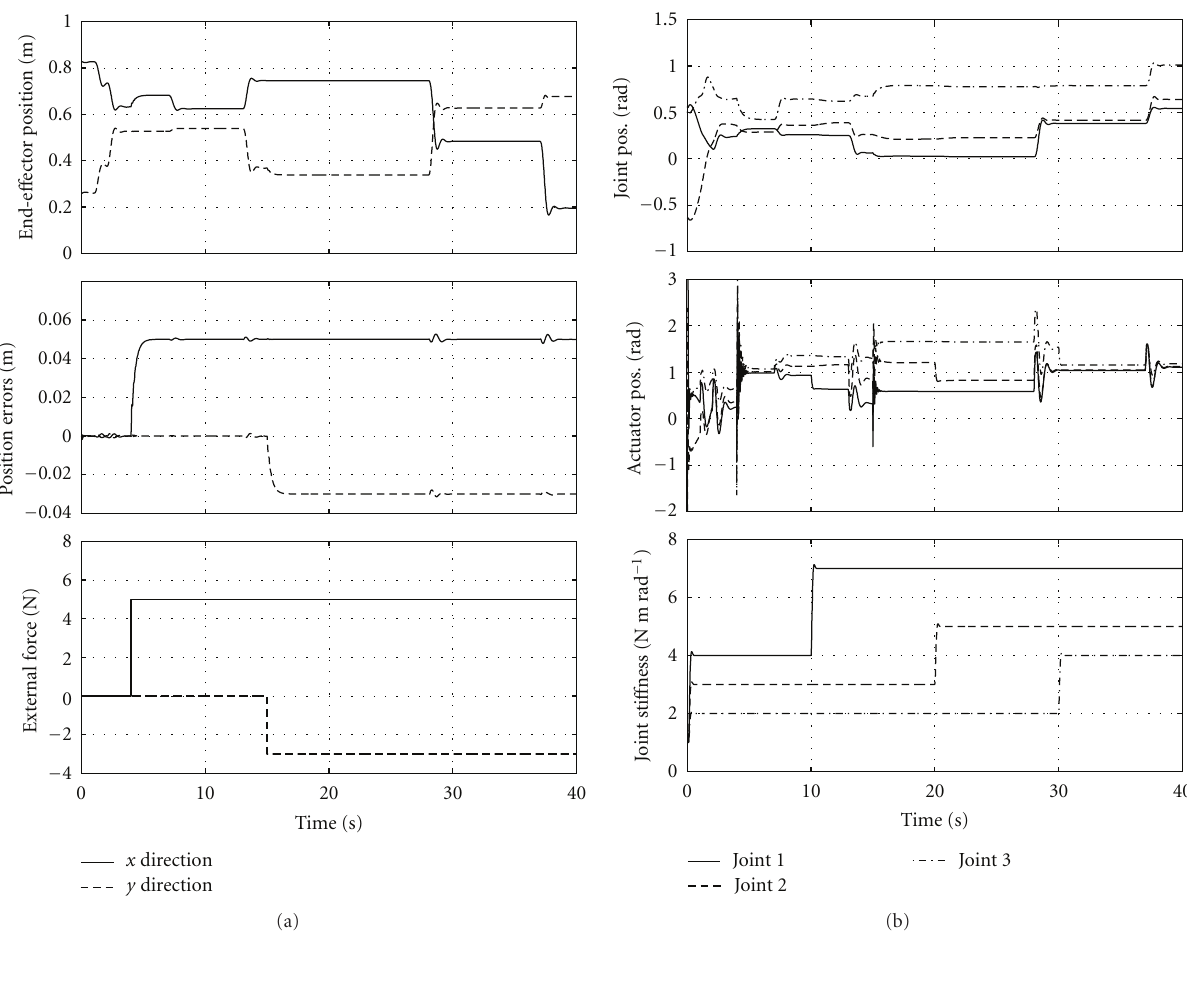
Figure 4: Response of the system during test no.